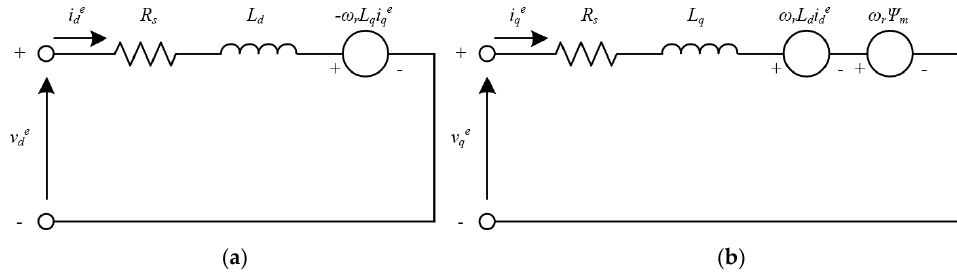
Figure 1. Equivalent circuit of permanent magnet synchronous motors (PMSMs): ( a ) d- axis; ( b ) q- axis. Assuming the steady-state condition, voltage Equation (1) can be approximated as Equation (2). It is noteworthy that ω r L d,q i ed,q are the coupling terms, and that ω r ψ m is the BEMF voltage. Based on Equation (2), the voltage and current vectors are described in Figure 2 [16].